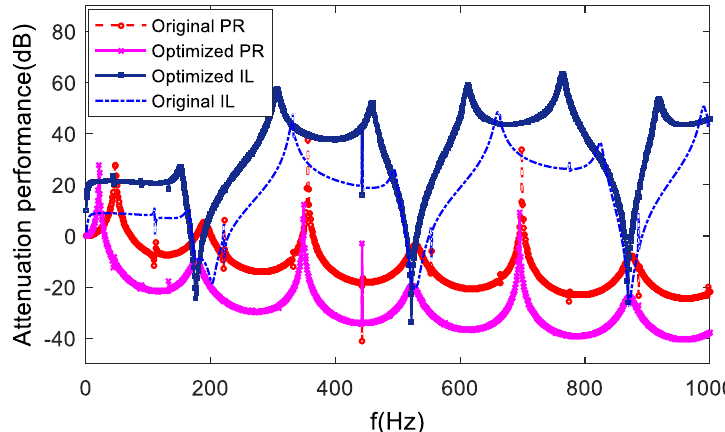
Figure 7. Attenuation performance of single-chamber RSHPA in OF 1